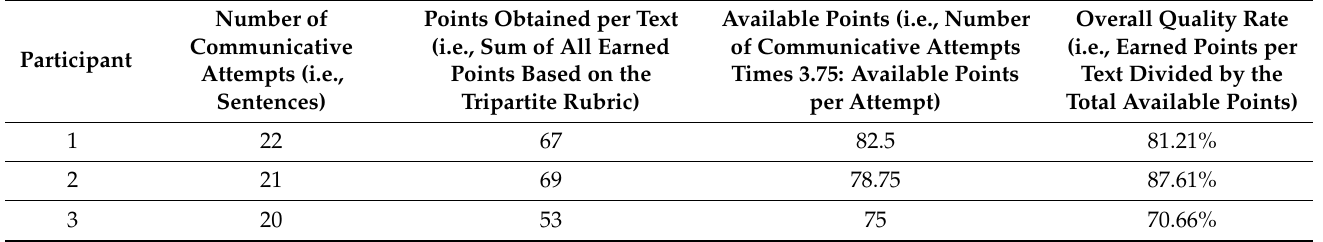
Table 4. Overall quality rates for draft 1.